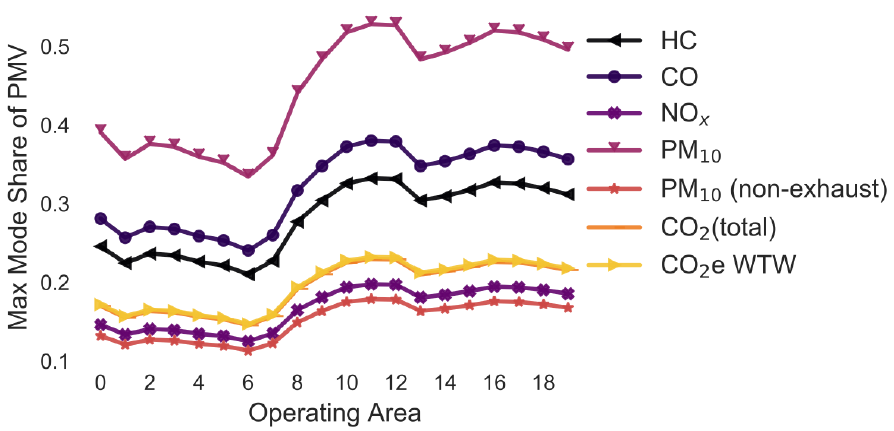
Figure 10. Maximum share of customers who can pick up a parcel by car (varying delivery vehicle drivetrain) (note: CO 2 (total) and CO 2 e WTW are the same).